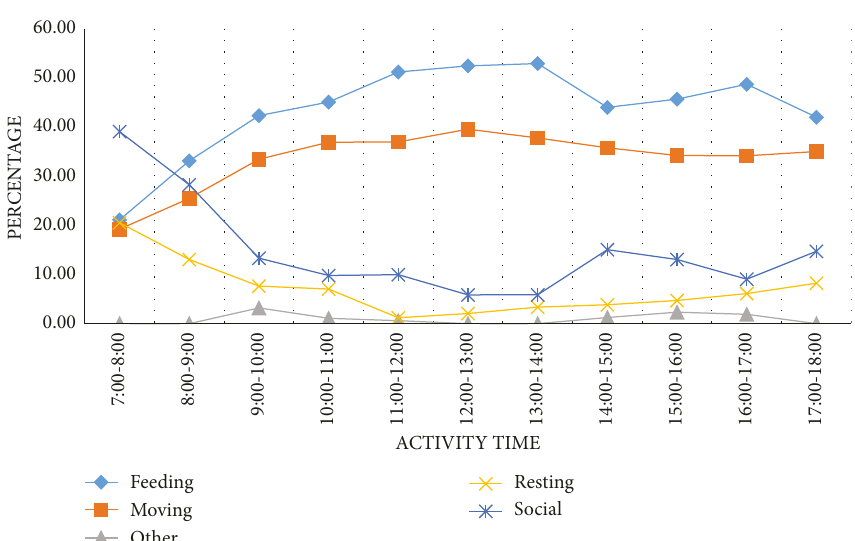
Figure 4: Daily activity pattern in nongrazed